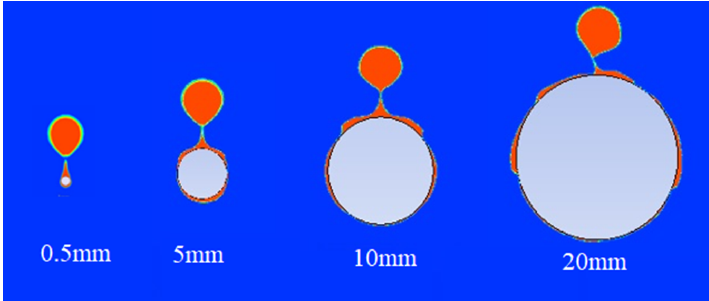
Figure 6. Bubble detachment shapes for various cylindrical diameters.